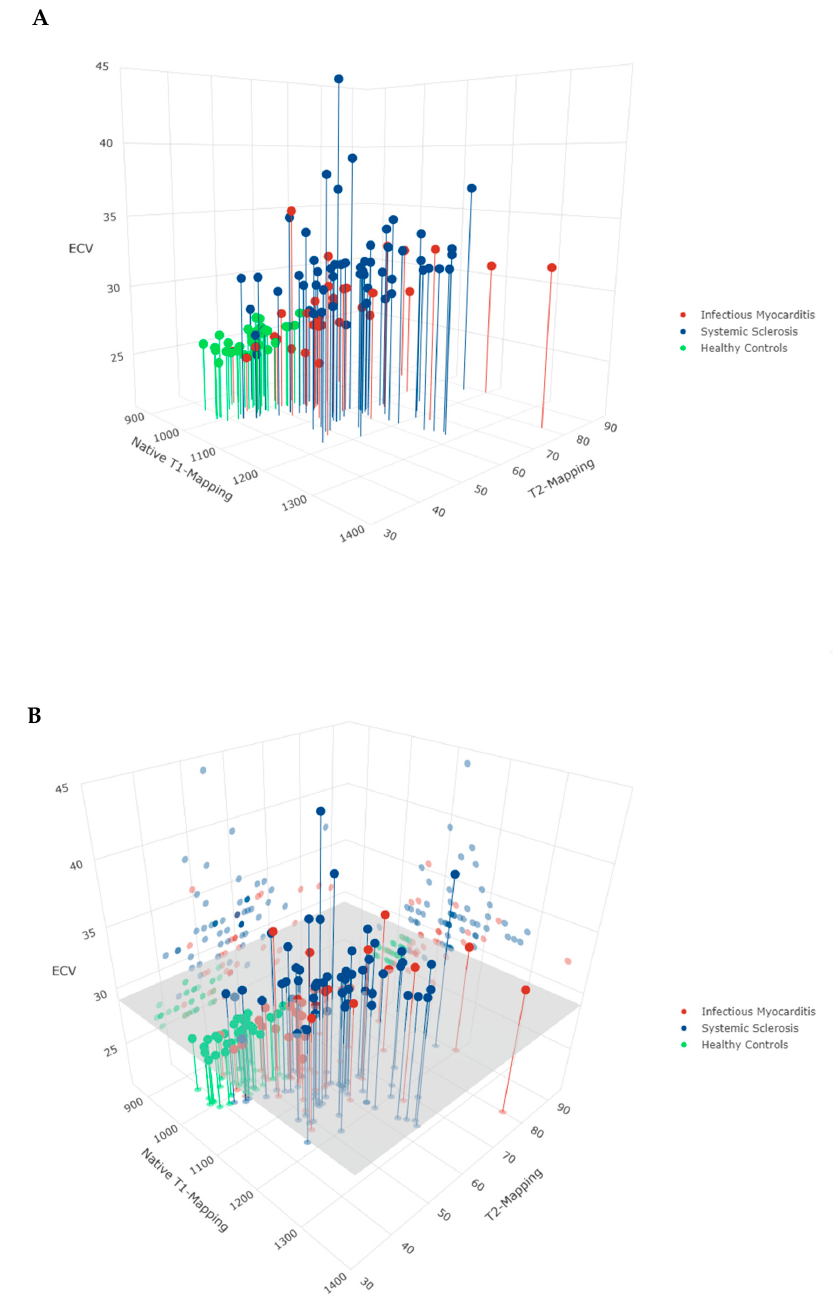
Figure 1. ( A ) A three-dimensional scatterplot of native T1-mapping (ms), T2-mapping (ms) and extracellular volume fraction (ECV) (%) values, colored by patient group. For each pairwise combination the corresponding point is projected on a side of the graph. ( B ) The same three-dimensional scatterplot with the addition of a horizontal plane at the pathologic cut-off value for ECV measurements used in this study (>29%). An interactive version of this plot is included as supplementary material. ms milliseconds